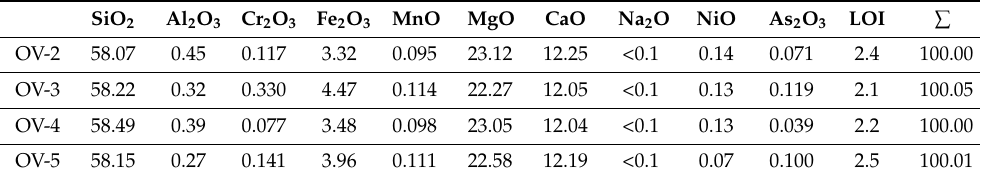
Table 4. Chemical composition of nephrite and transitional tremolite rock (wt. %).